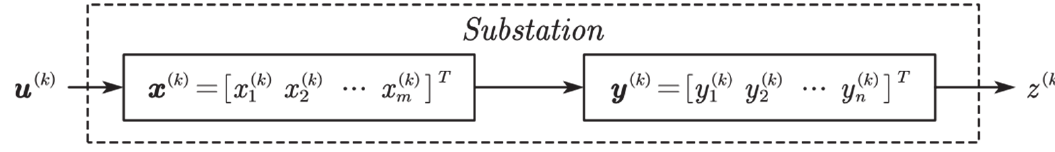
Figure 2. Multi-variable discrete-time linear time-invariant model of smart substation.